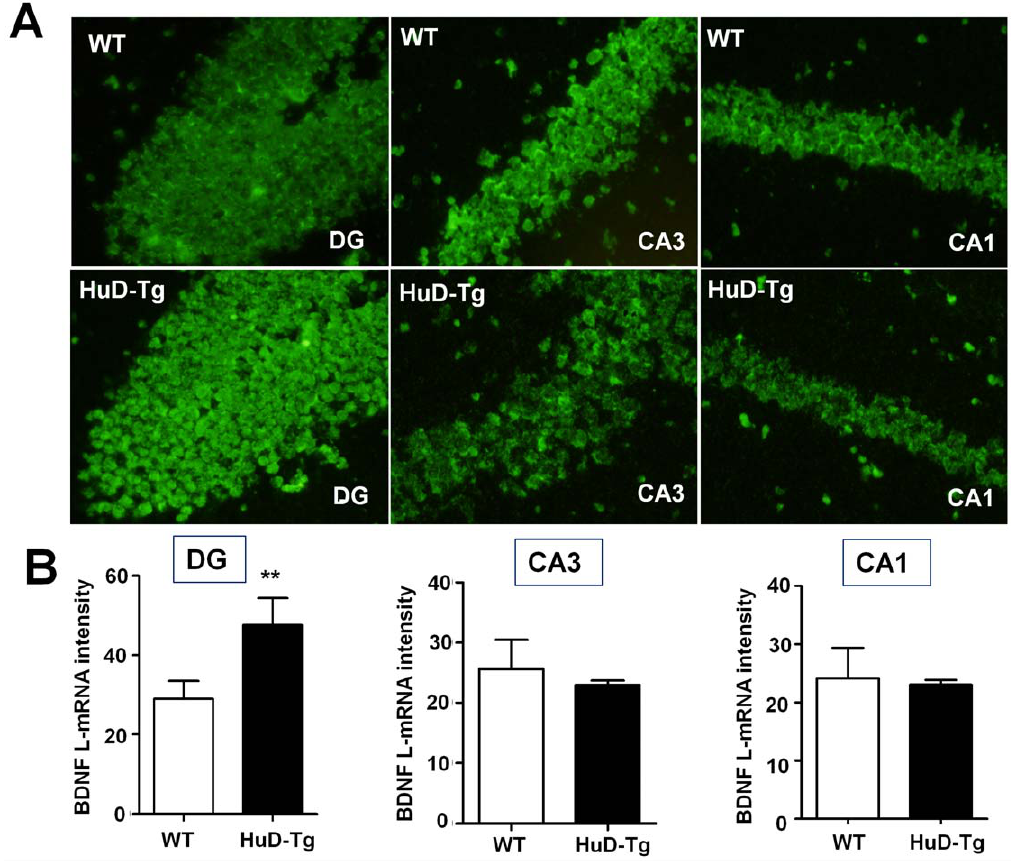
Figure 6. A HuD transgene enhances expression of the BDNF long 3 9 UTR mRNA in hippocampal DGCs. (A) Representative FISH images of fluorescent in situ hybridization of BDNF long 3 9 UTR mRNA in the neuronal soma layers of hippocampal DG, CA3 and CA1 of HuD-Tg and WT littermates (scale bar=75 m m). (B) Quantification of FISH intensity in four pairs of HuD-Tg and WT controls. ** p , 0.01 (Student’s t-test, n=4).